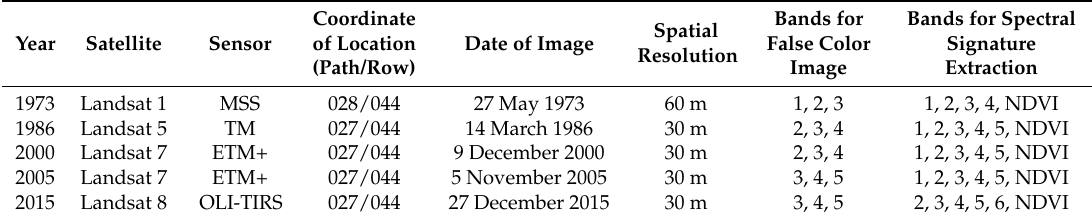
Table 1. Details of the Landsat images and some parameters used for the analysis of land use-cover change in the Natural Protected Area Altas Cumbres and adjacent areas. Tamaulipas,